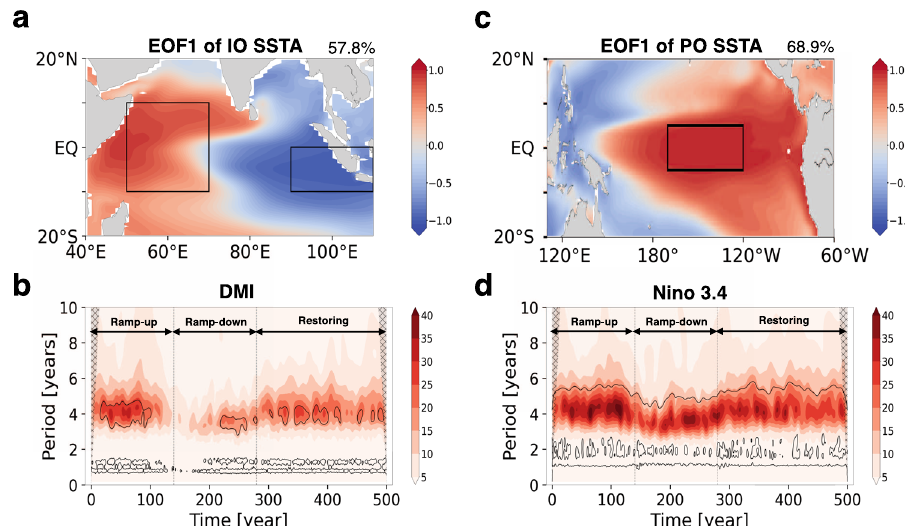
Fig. 1 IOD and ENSO patterns and Wavelet Spectrum. First empirical orthogonal function (EOF) mode of a September – October – November mean SST anomalies for tropical Indian Ocean and c December – January – February mean SST anomalies for tropical Paci fi c Ocean obtained from Present-Day simulation. Variance explained by EOF mode (%) is shown in upper right corner of each panel. Boxes in a and c indicate the areas averaged for each index. Wavelet Power Spectrum (Morlet) of b DMI anomaly and d Nino3.4 anomaly (average SST anomalies over 5° N – 5°S and 170° – 120°). b and d were obtained from CDR-reversibility experiments of CESM1.2. Ramp-up, ramp-down, and restoring indicate an increase in CO 2 , decrease in CO 2 , and constant CO 2